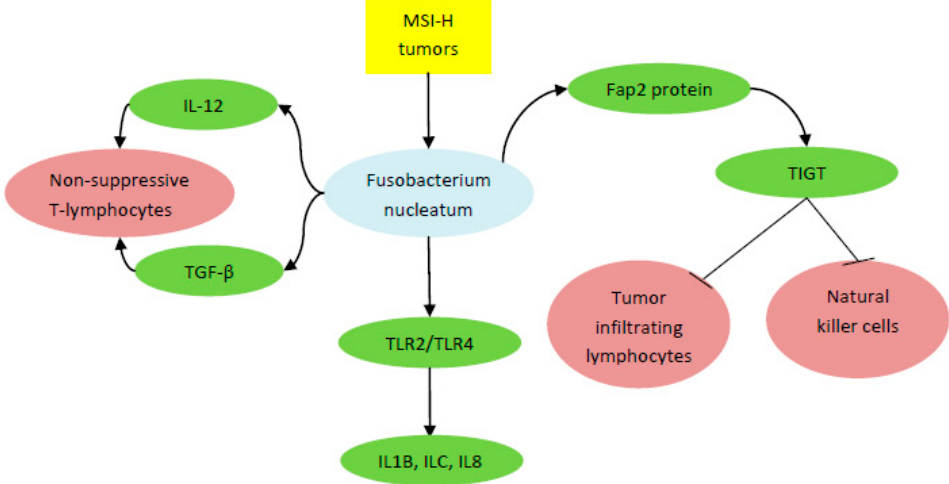
Figure 2. Fusobacterium correlated with poor outcome in high microsatellite instability (MSI-H) colorectal tumors by activating inflammatory mediators (interleukin (IL)1B, IL6, and IL8), secreting IL-12 and transforming growth factor β (TGF- β ), and inhibiting natural killer cells and tumor infiltrating lymphocytes. TLR, Toll-like receptor.